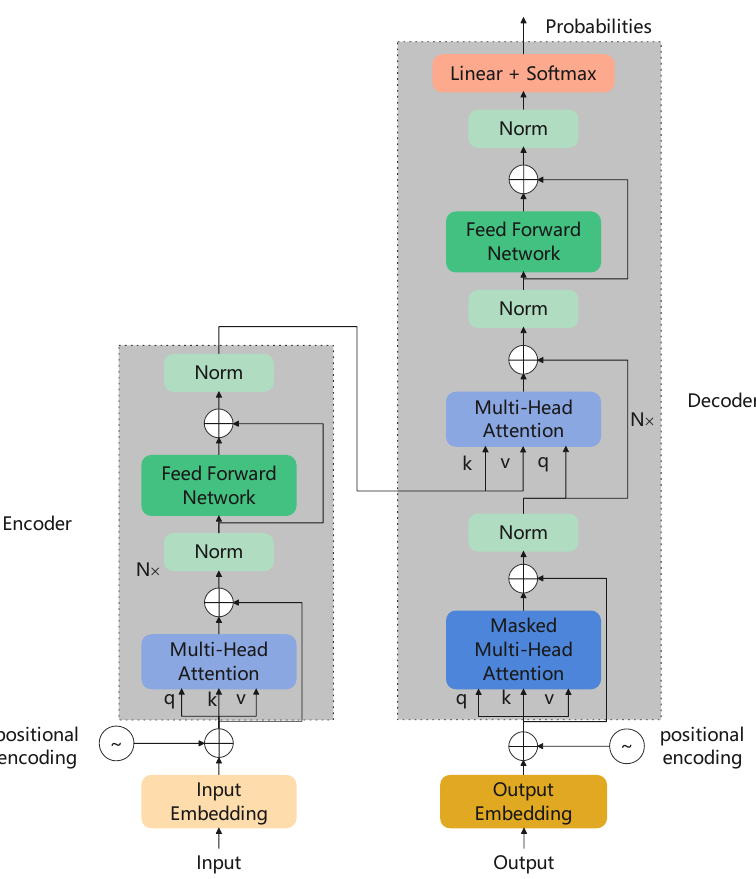
Figure 2. The structure of the original